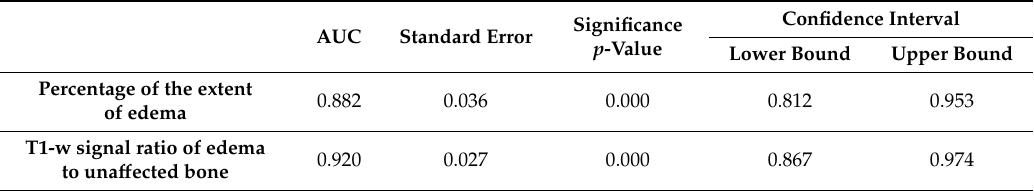
Table 4. Receiver-operating characteristic (ROC) analysis of the percentage of edema extent and T1-w signal ratio of edema to una ff ected bone for the di ff erentiation between MT1 and